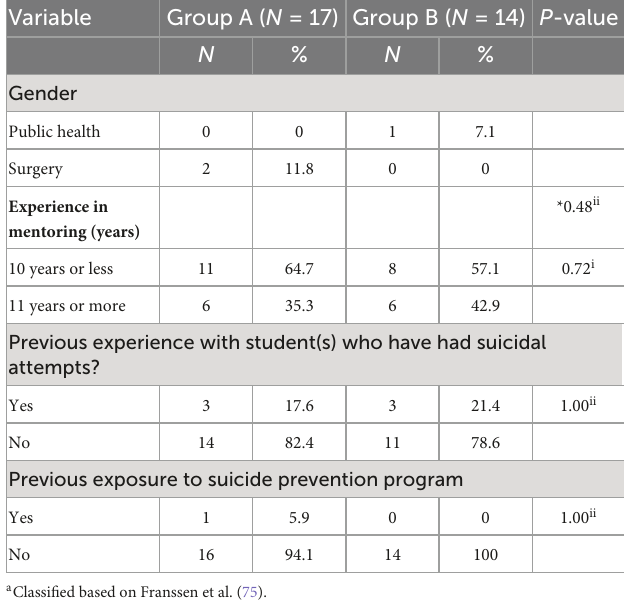
TABLE 1 Sociodemographic description of participants in the study ( N = 31). Variable